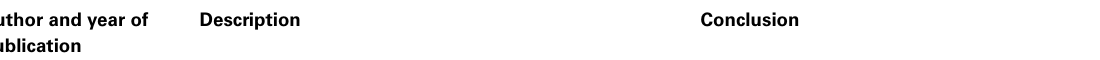
Table 1 | Clinical trials and other human and animal studies of safety of Echinacea sp. in